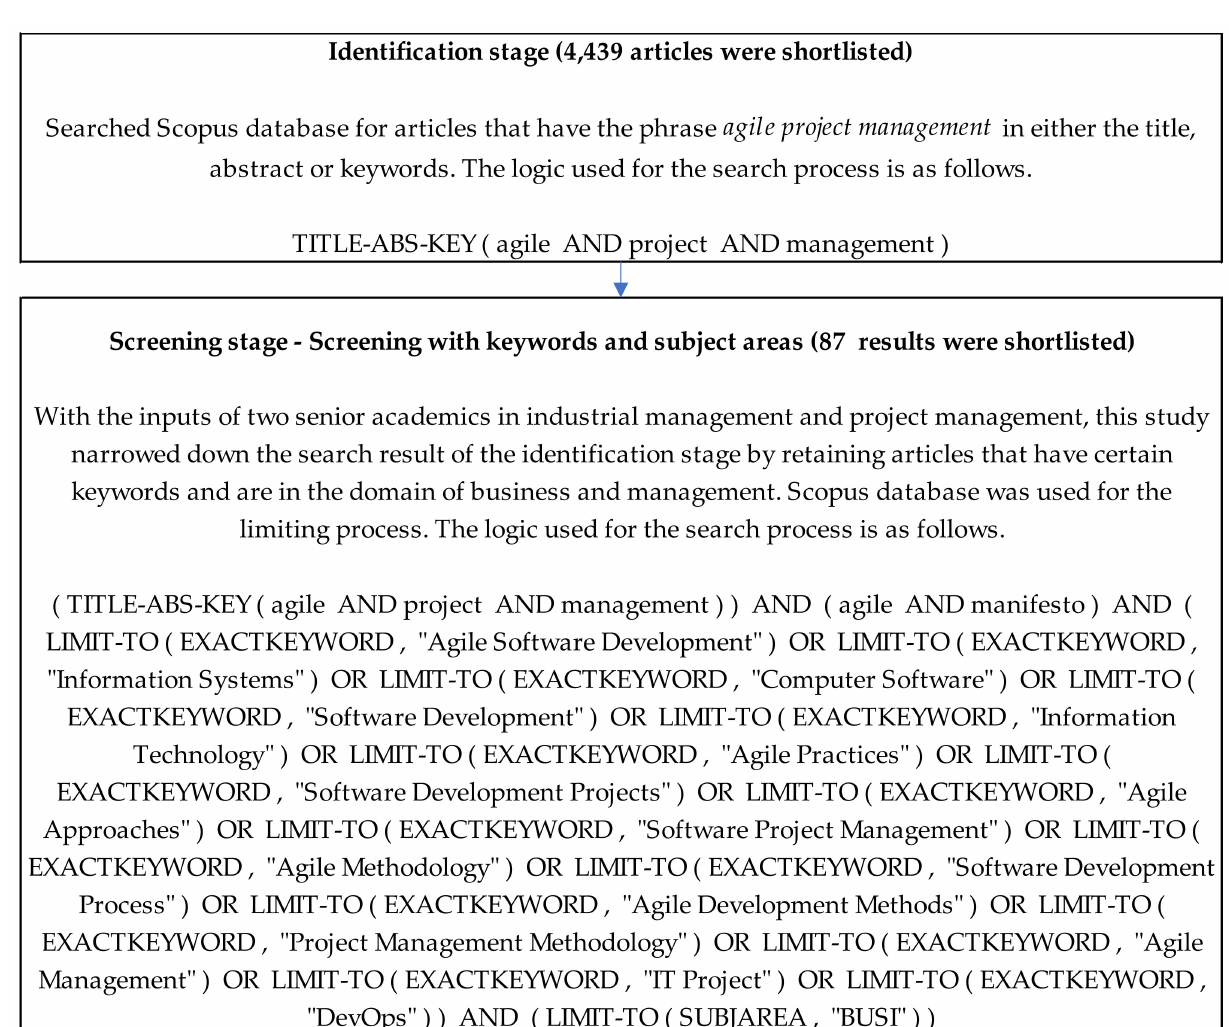
Figure 1. Summary of the article search